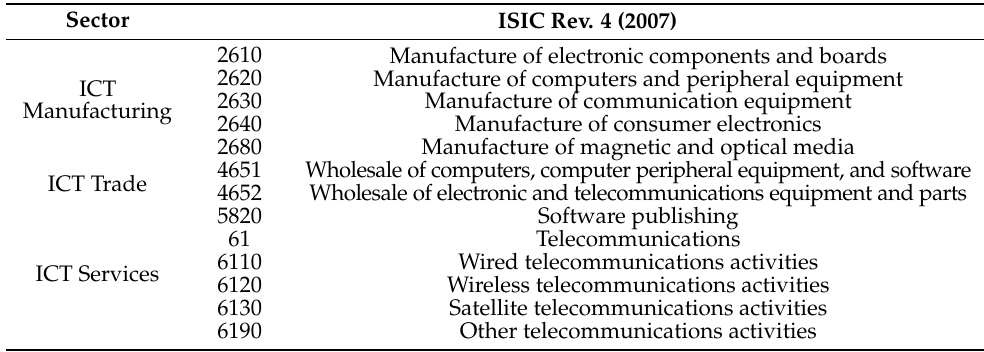
Table 3. The list of ICT industries (ISIC Rev. 4).